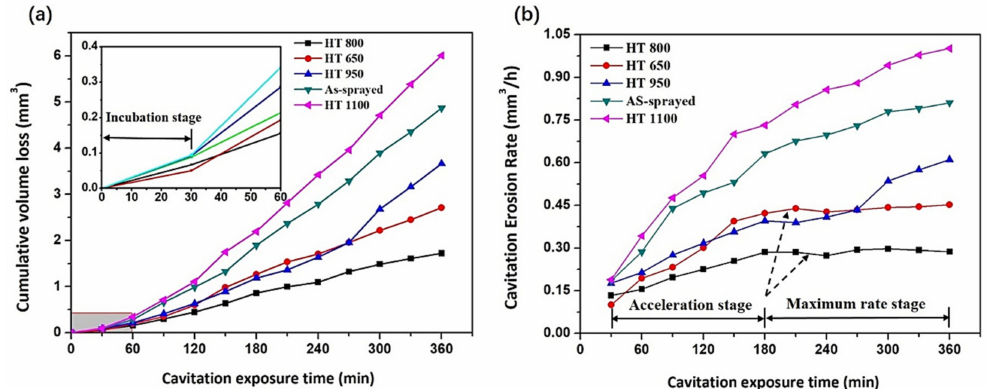
Figure 8. Volume loss ( a ) and cavitation erosion rate ( b ) of all the coatings in relationship with cavitation